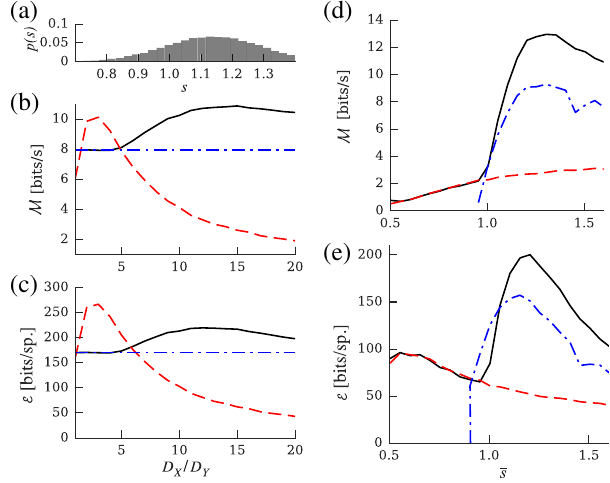
FIG. 5. Stochastic resonance for wide input distributions. (a) Input distribution of the GP chosen to cover a large range around a high mean ¯ s . Using the same color code as in Fig. 3, (b) shows M and (c) shows E (in bits per spikes) for different D calculated with input distribution in (a). We restrict X the range for intrinsic noise such that the standard deviation of u X remains smaller than 0.5, which would correspond to substantial membrane potential fluctuations in physical units. (d) M and (e) E for different values of the mean input and for a fixed level of 15 D intrinsic noise D . Parameters are described in X ¼ Y